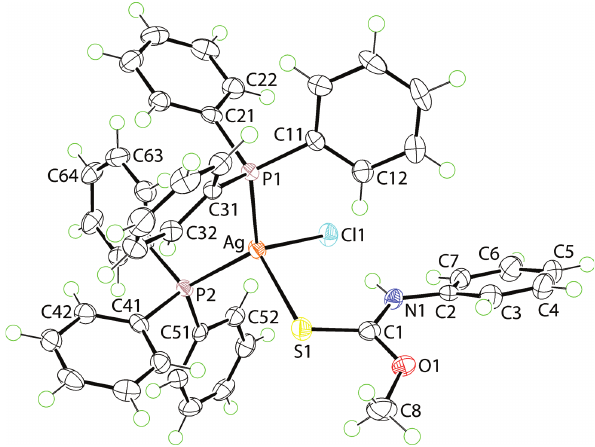
Table 2: Fractional atomic coordinates and isotropic or equivalent isotropic displacement parameters (Å 2